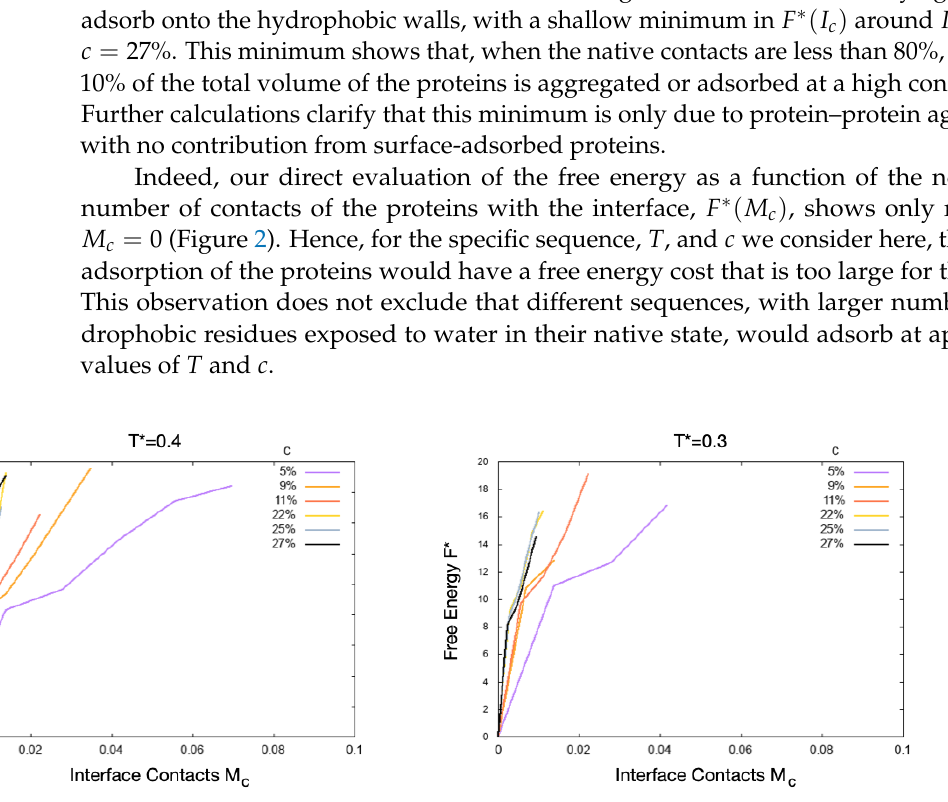
Figure 2. Free energy profiles as a function of the normalized number, M c , of contacts of the proteins with the hydrophobic interfaces. Colors for the concentrations are as in Figure 1. The proteins are not adsorbed onto the interfaces when the minimum is at M c =